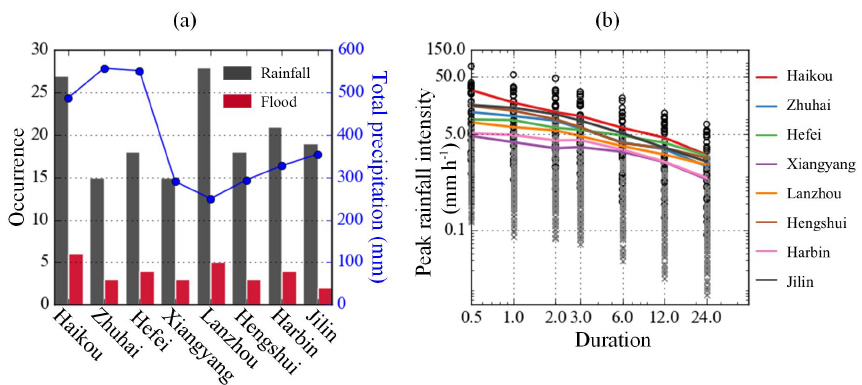
Figure 2. Total precipitation and the frequency of rainfall and city flooding events in August (a) . Variations in peak rainfall intensity (circles) and the flood-triggering precipitation threshold values (lines) are derived from time windows ranging from 0.5 to 24h (b)